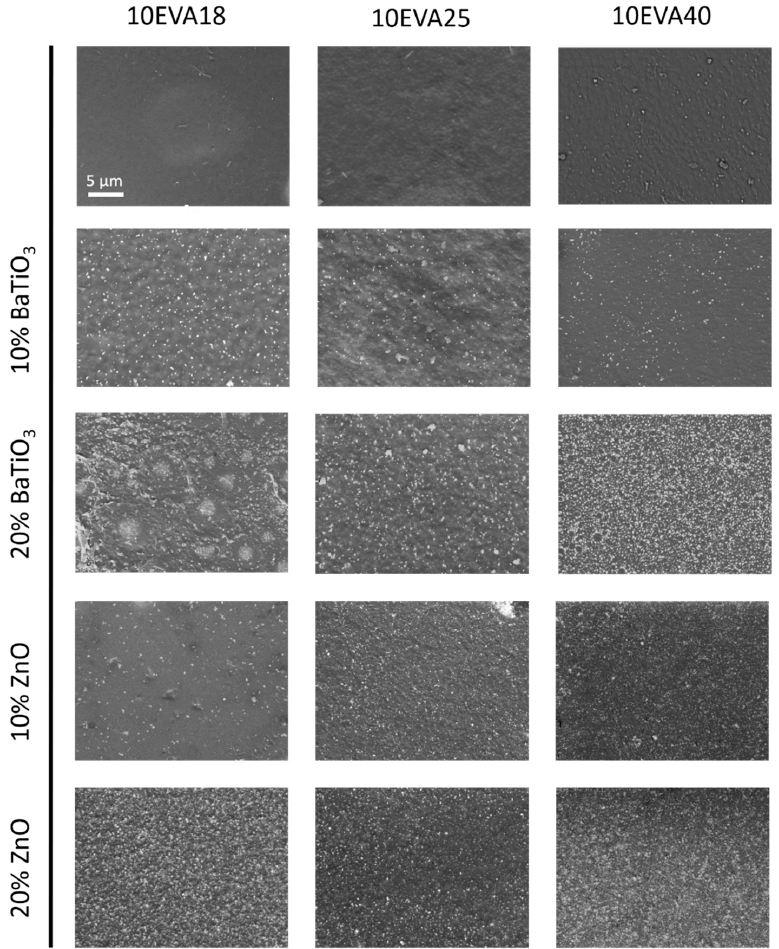
Figure 2. Scanning electron microscopy (SEM) images of each 10EVA formulation.